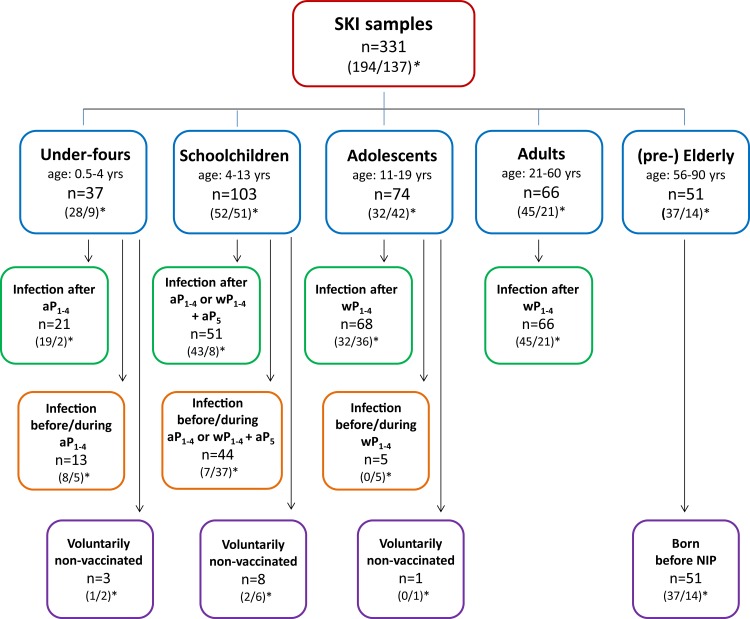
Flowchart of SKI samples stratified according to age and vaccination status.Fourtyfour percent of all SKI samples were from male (ex-)cases. (1,2)*: first number: number of cases having τ <24 months; second number: number of cases having τ ≥ 24 months. aP1-4: acellular pertussis vaccination doses 1–4; aP5: acellular pertussis preschool booster dose 5; wP1-4: whole cell pertussis vaccination doses 1–4. According to the Dutch National Immunization Program (NIP) pertussis vaccine primary doses 1–4 are given at 2,3,4, and 11 months of age, and the preschool booster dose 5 is given at 4 yrs of age.